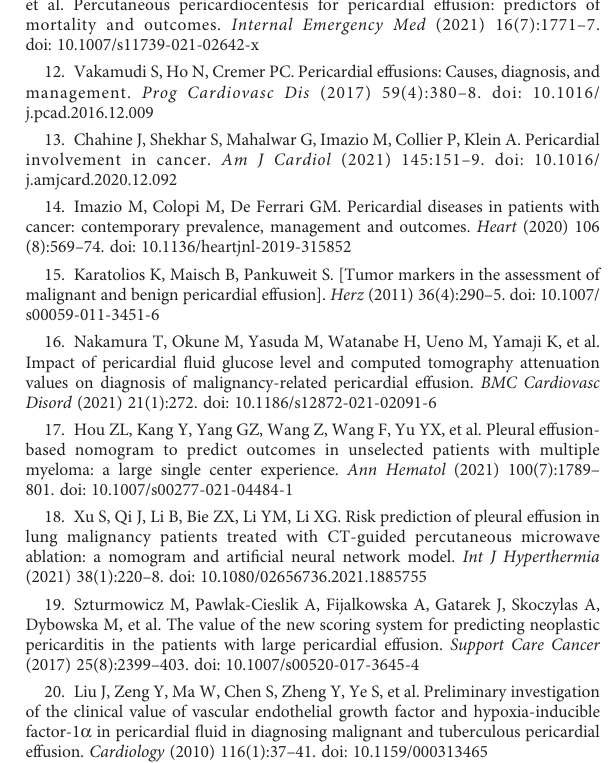
SUPPLEMENTARY FIGURE 1 Receiver operative characteristic (ROC) analysis were used to determine the optimal cut-offs of categorical variables. age (A) , effusion TP (B) , effusion ALB (C) , effusion ADA (D) , effusion GLU (E) , effusion LDH (F) , effusion CEA (G) , TP (H) , ALB (I) , ADA (J) , GLU (K) , LDH (L) , CEA (M) , hs- CRP (N) , ESR (O) and Karyocyte count (P)